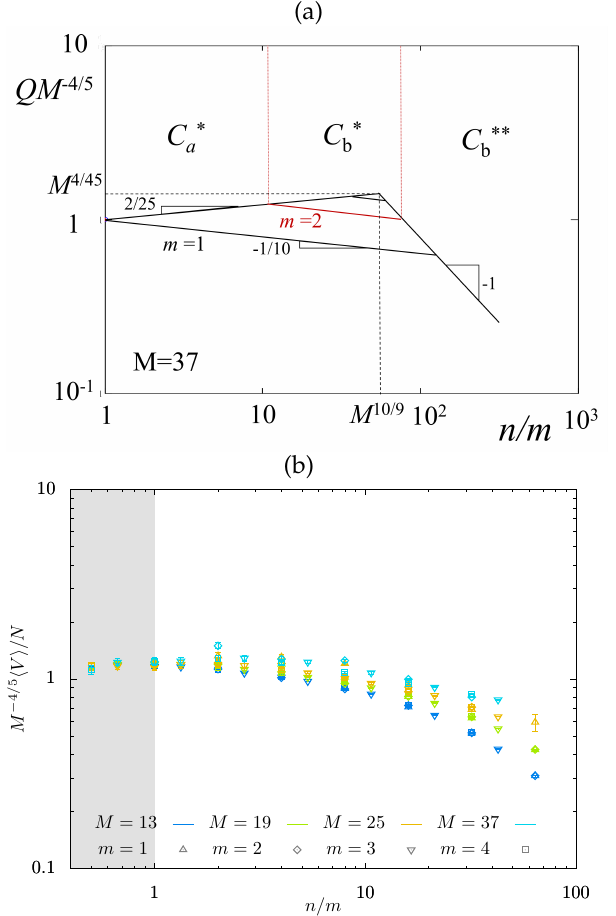
Figure 7. Theoretical ( a ) and MC-simulated ( b ) swelling coefficient Q as a function of n / m . Scaling dependences for theoretical Q (with all numerical coefficients equal to unity) were calculated for M = 37. C ∗ a C ∗ C ∗∗ and C ∗ boundaries are indicated for m = 2. b b − b −